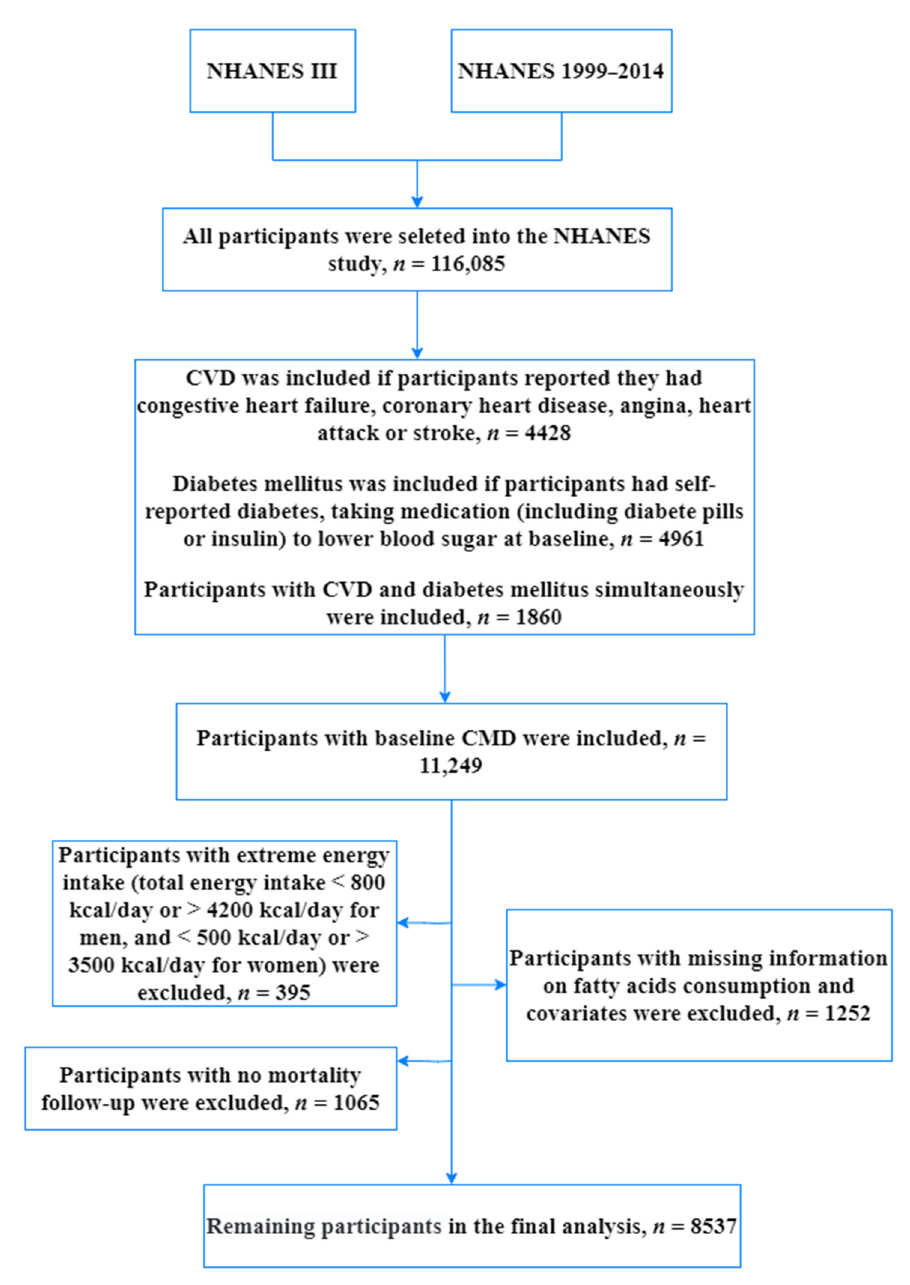
Figure 1. The flow chart of selecting a full analysis set.